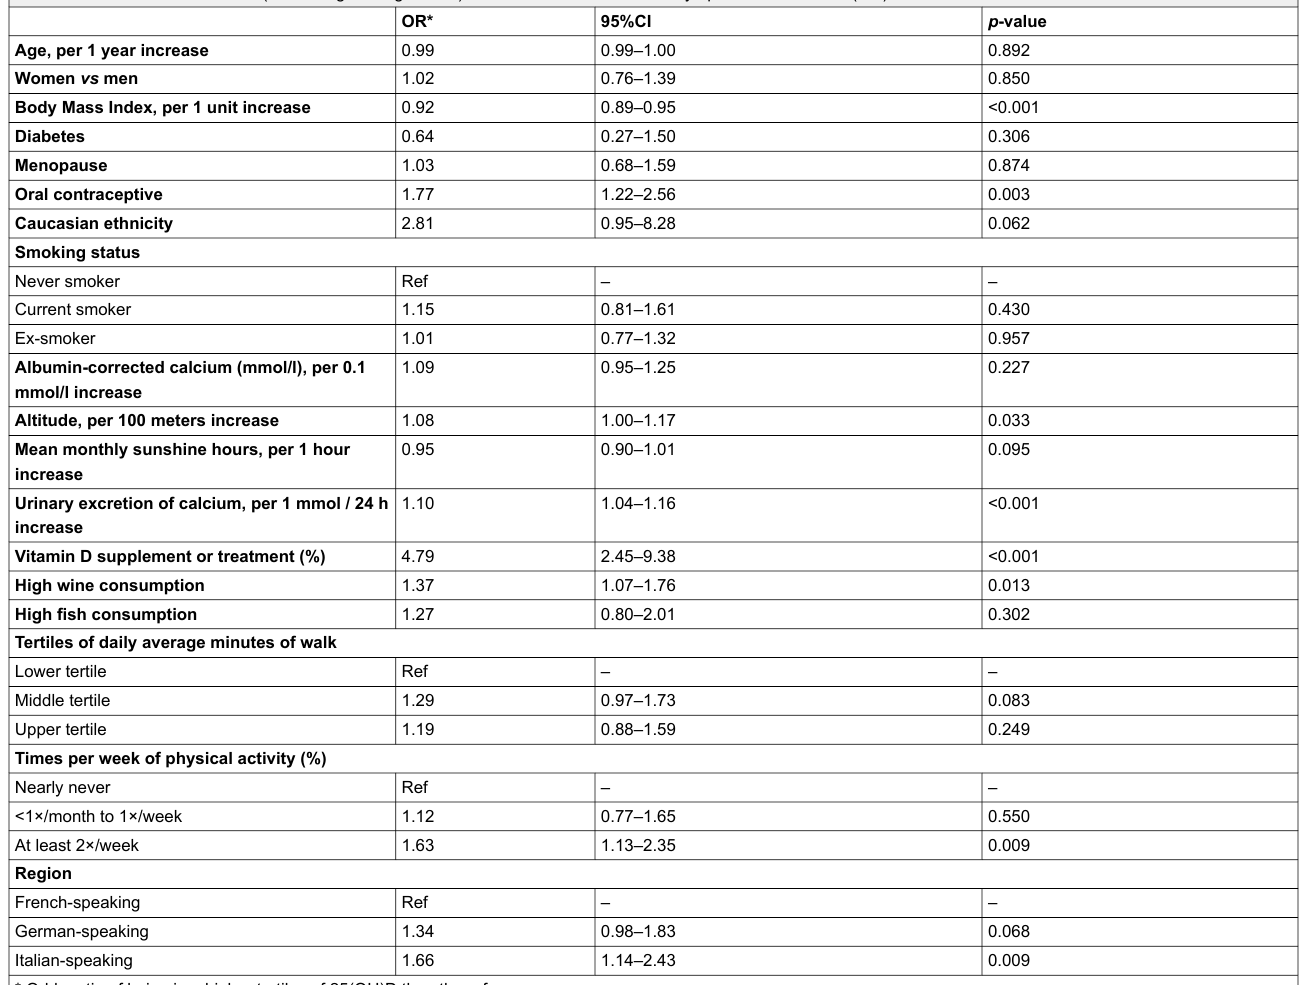
Table 4: Multivariate association (ordinal logistic regression) of characteristics with monthly-specific tertiles of 25(OH)D. OR* 95%CI p